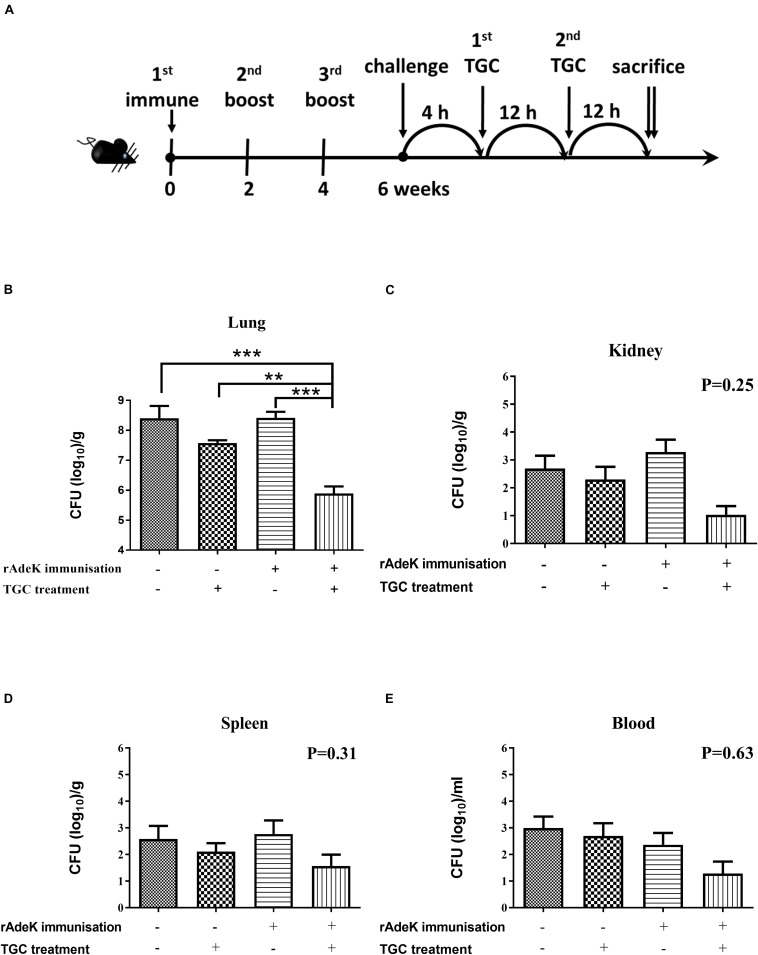
The efficacy of rAdeK immunization in a mouse pneumonia model. (A) Rational design of the animal model. Treatment was initiated 4 h after challenge against A. baumannii AB247 [tigecycline (TGC) minimum inhibitory concentration of 16 μg/mL], twice a day by subcutaneous injections. Bacterial loads were determined in different organs after the mice were sacrificed and were compared among the four groups. (B–E) Bacterial load in the mice lungs (B), kidney (C), spleen (D), and blood (E) after 24 h TGC treatment compared among the four groups studied. The bars indicate the means ± the SEM. **p < 0.01; ***p < 0.001.